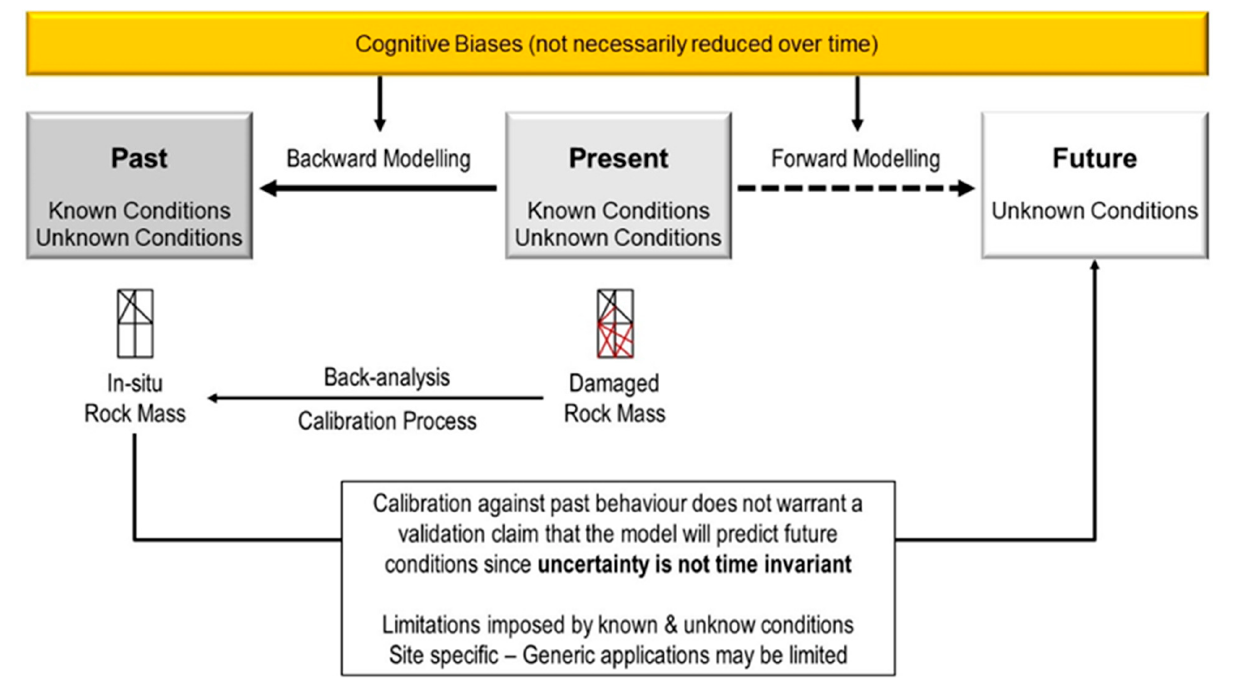
Figure 6. Relationship between backward and forward modelling.